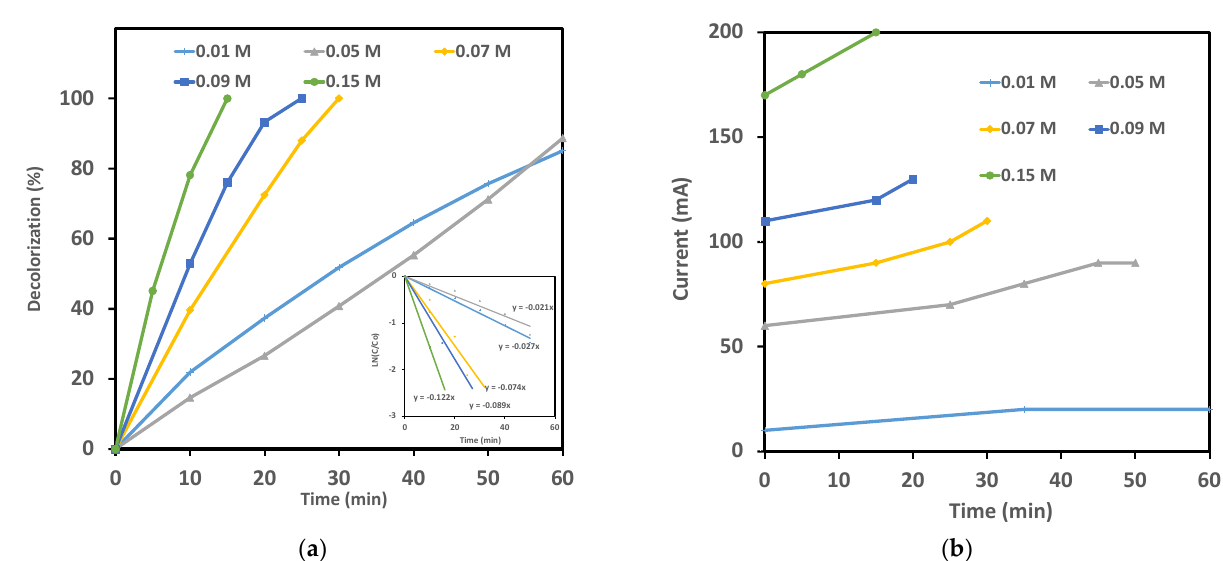
Figure 9. ( a ) Effects of concentration of Na 2 SO 4 on decolorization efficiency. Na 2 SO 4 electrolyte: 0.01~0.15 mol L −1 ; reaction time: 1 h; electrode distance: 3 cm; initial pH: 6.0; reaction temperature: 25 °C; MB: 9 mg L −1 ; and cell voltage: 20 V. ( b ) Current vs. treatment times.